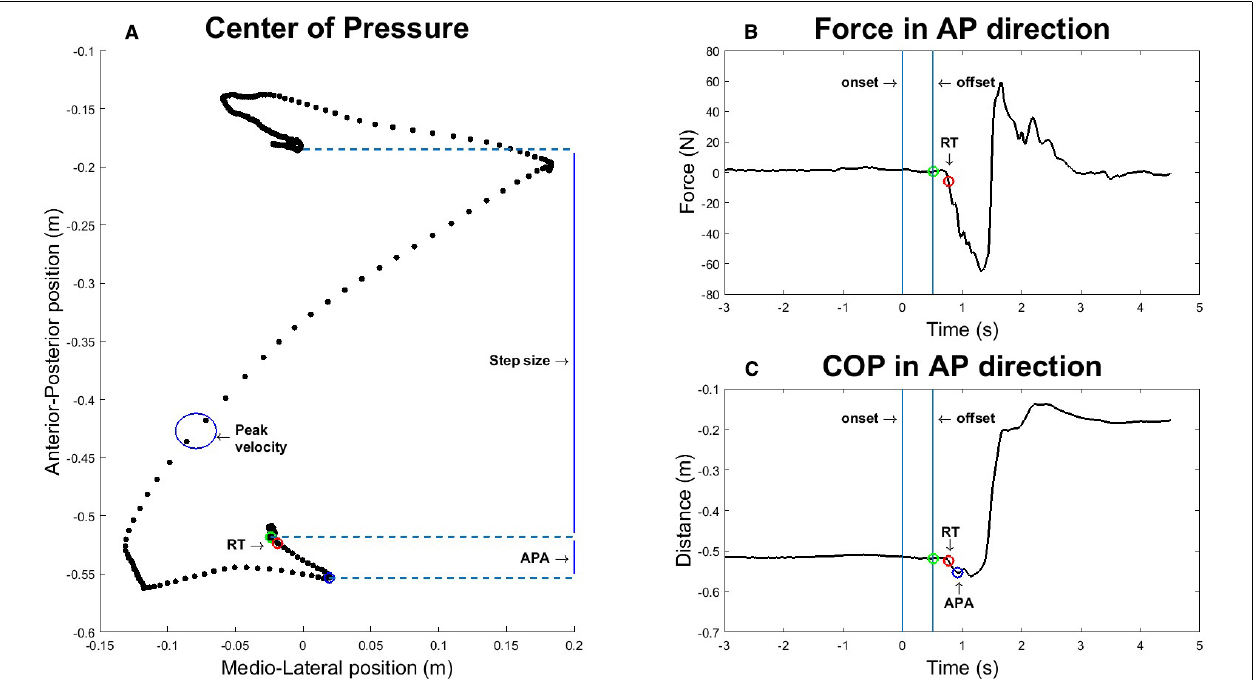
FIGURE 2 | Graphic representation of how the four dependent variables are extracted from a representative step after a stimulus duration of 500 ms. (A) Center of Pressure (COP) in anterior-posterior (AP) and medio-lateral (ML) direction over time. (B) Force exerted by the participant in AP direction. (C) COP in AP direction over time.